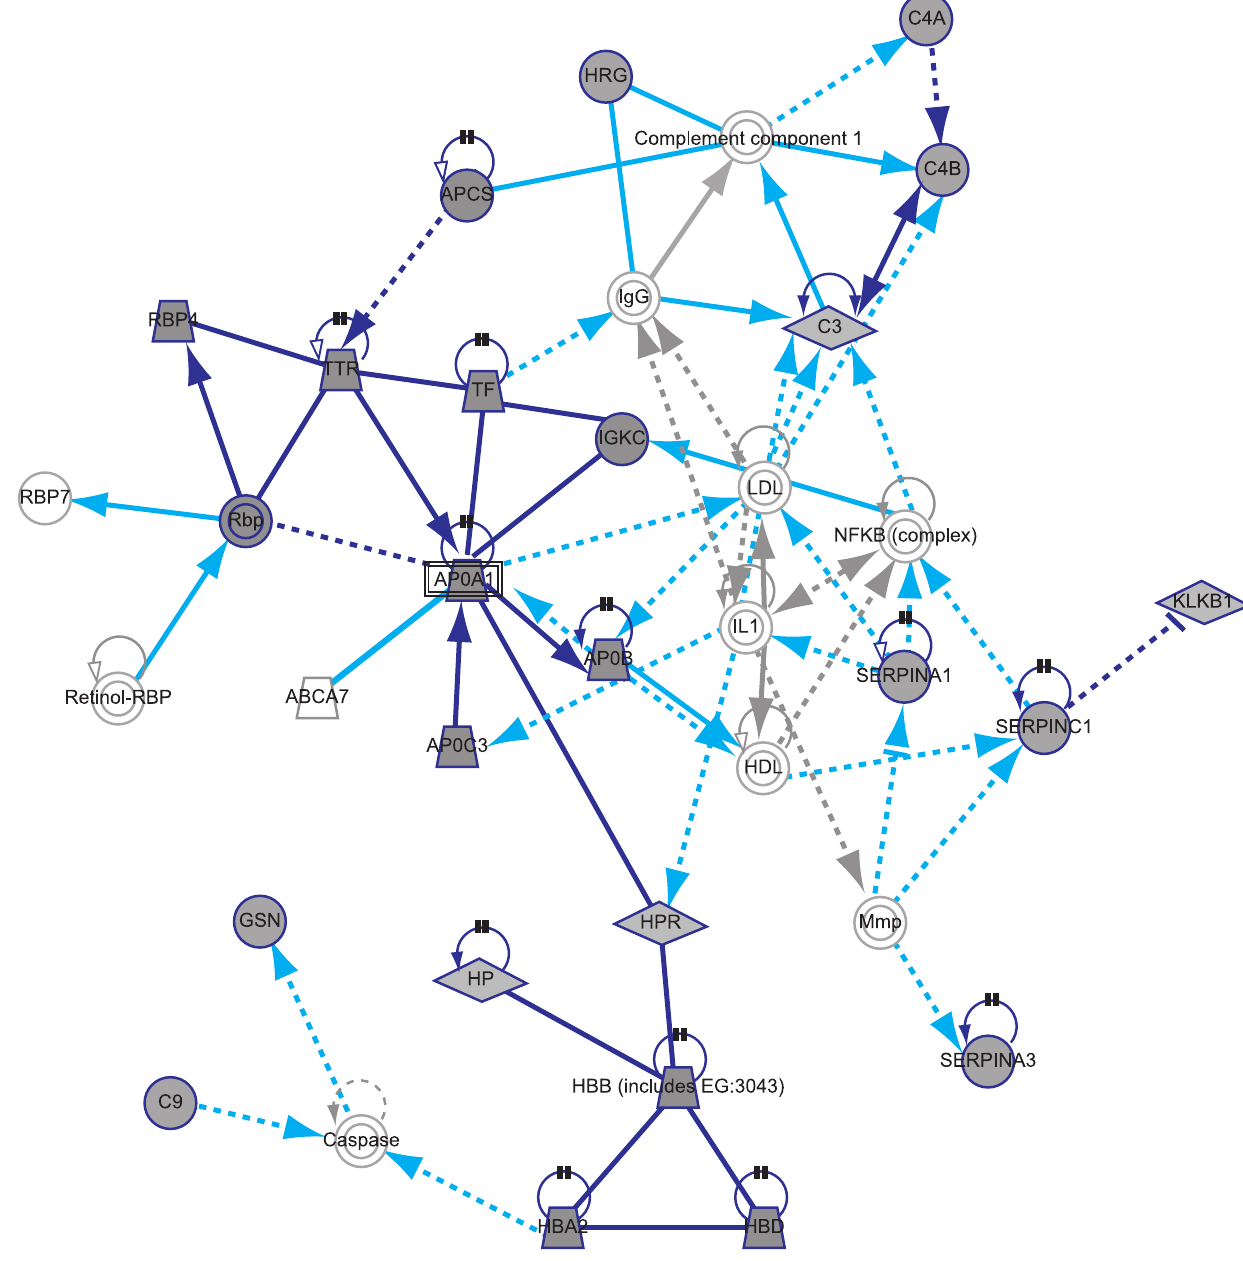
Figure 5. Highest scoring Ingenuity Pathway Analysis network. Highest scoring network generated from entering the identified 29 proteins into the Ingenuity Pathway Analysis system, with proteins identified in the study shaded grey and connecting proteins identified by Ingenuity Pathway Analysis non-shaded. Dark blue shapes and lines = proteins identified as predictors in this study and interactions between them. Grey shapes and lines = proteins identified by Ingenuity to generate the network and interactions between them. Light blue lines = interactions between proteins identified by Ingenuity to generate the network and the proteins identified in the study. Figure S4A shows this figure with the interaction relationships labeled. Proteins identified in the study and included in the network: SERPINA1 = alpha-1-antitrypsin; SERPINA3 = alpha-1- antichymotrypsin; SERPINC1 = antithrombin-III; APOA1 = apolipoprotein A-I; APOB = apolipoprotein B-100; APOC3 = apolipoprotein C-III; C3 = complement C3; C4A, C4B = complement C4-A; complement C4-B; C9 = complement component C9; GSN = gelsolin; HBA2 = hemoglobin alpha; HBB, HBD = hemoglobin beta/delta; HP = haptoglobin; HPR = haptoglobin-related protein; HRG = histidine-rich glycoprotein; KLKB1 = plasma kallikrein; IGKC = Ig kappa chain V-III region Ti; RBP4, Rbp = retinol binding protein 4; APCS = serum amyloid P-component; TF = serotransferrin; TTR = transthyretin. Proteins identified in the study and not included in the network: ORM1 = alpha-1-acid glycoprotein 1; A1BG = alpha-1B- glycoprotein; LRG1 = leucine-rich alpha-2-glycoprotein; ARMC2 = armadillo repeat-containing protein 2; AHSG = alpha-2-HS-glycoprotein; ITIH4 = inter-alpha-trypsin inhibitor heavy chain H4.